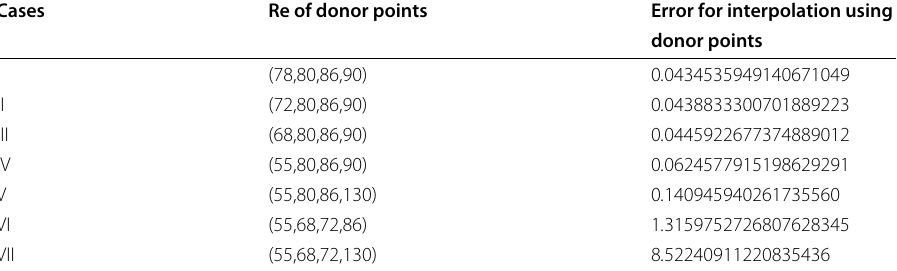
Table 2 RMS error estimates of interpolation for Re =